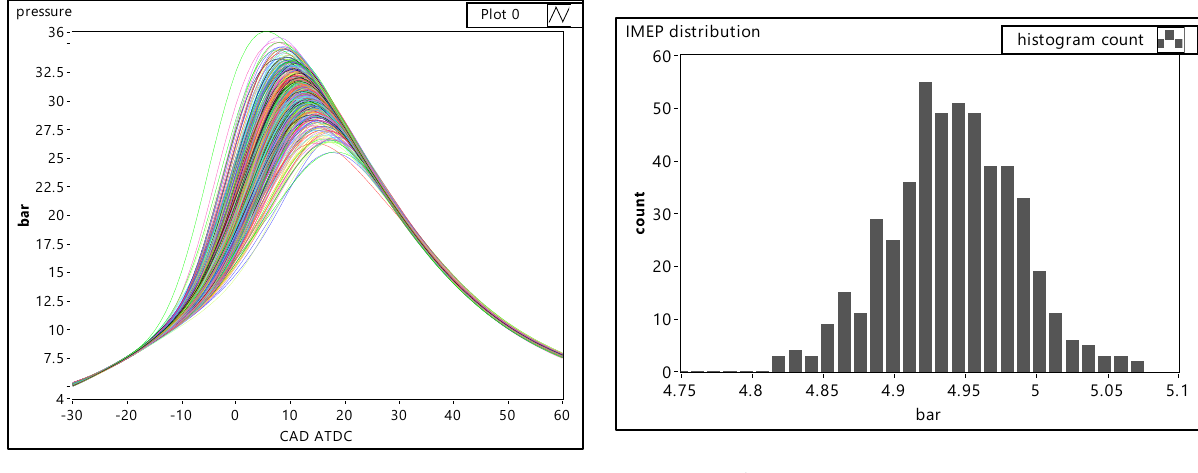
Figure 8. MAP = 0.5 bar, engine speed n = 3000 rpm.